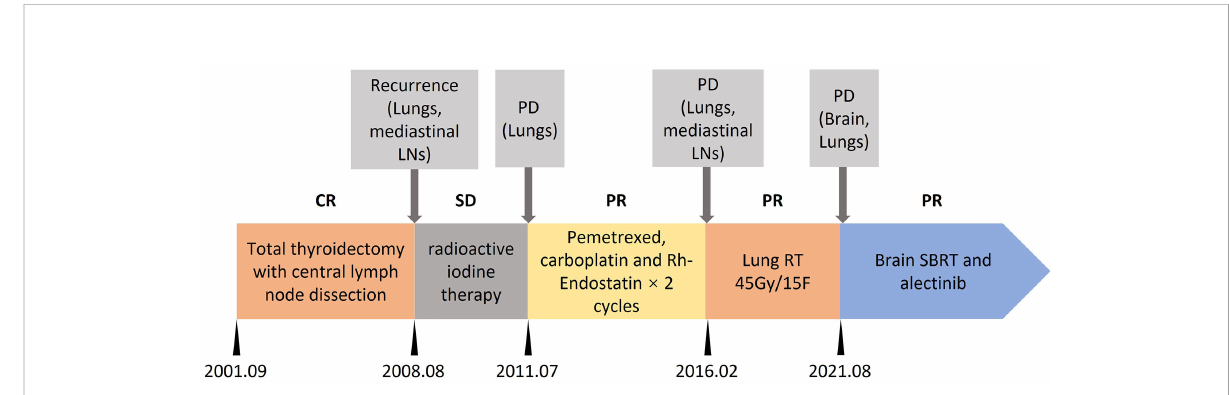
FIGURE 1 Treatment timeline. CR, complete response; SD, stable disease; PD, progression disease; PR, partial response; LNs, lymph nodes; RT, radiotherapy; SBRT, stereotactic body